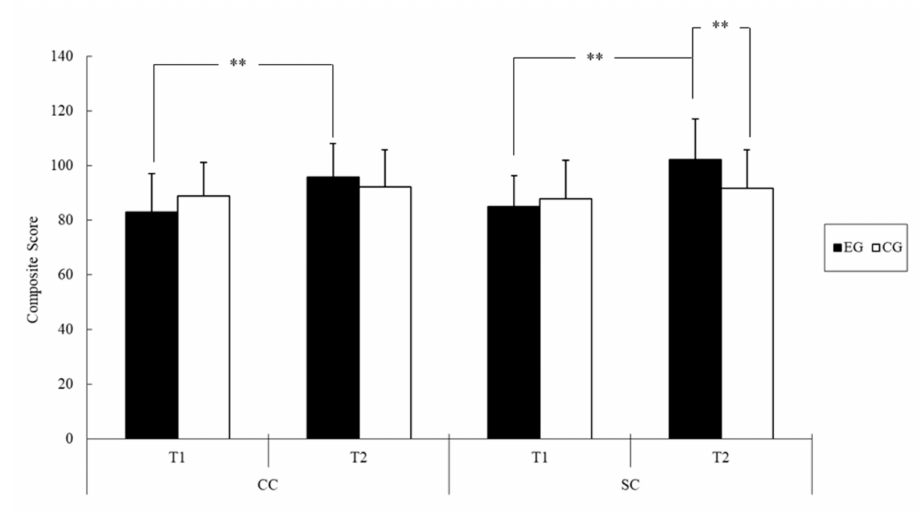
Figure 3. The adaptive development composite score of two groups of youths with IDs before (T1) and after the intervention (T2); ** p < 0.01 (Abbreviations: CC = conceptual composite; SC = social composite; EG = exercise group; CG = control